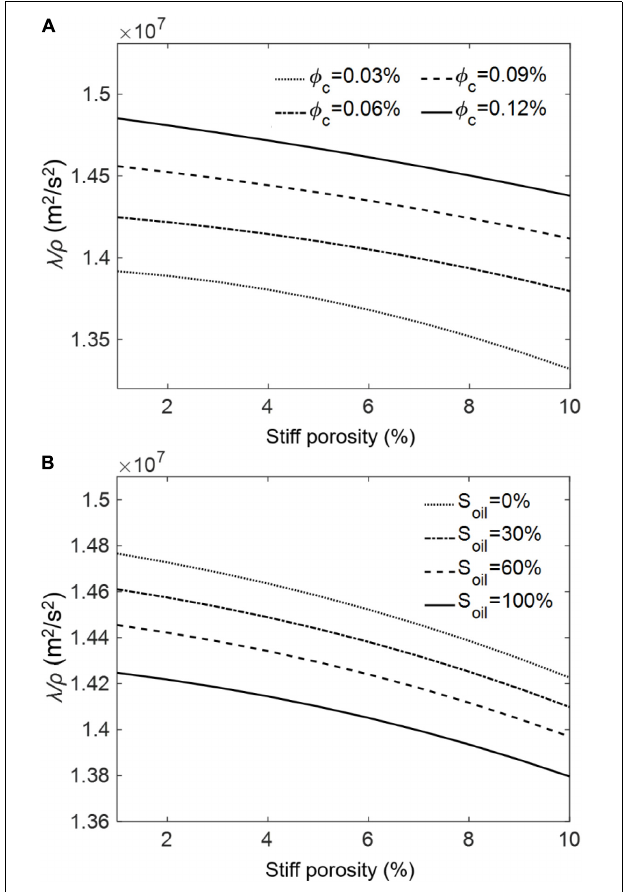
FIGURE 6 | λ / ρ at 1 MHz as a function of stiff porosity for different crack (soft) porosities (A) and oil saturations (B) .